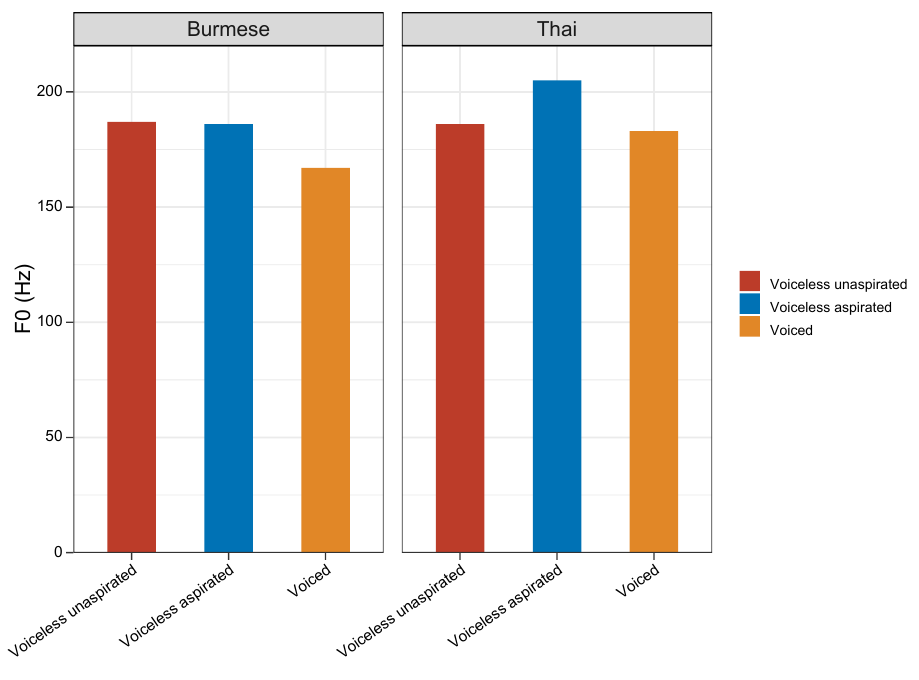
Figure 2. F0 onsets across three laryngeal categories of Burmese and Thai (average values based on Shimizu 1989, p.